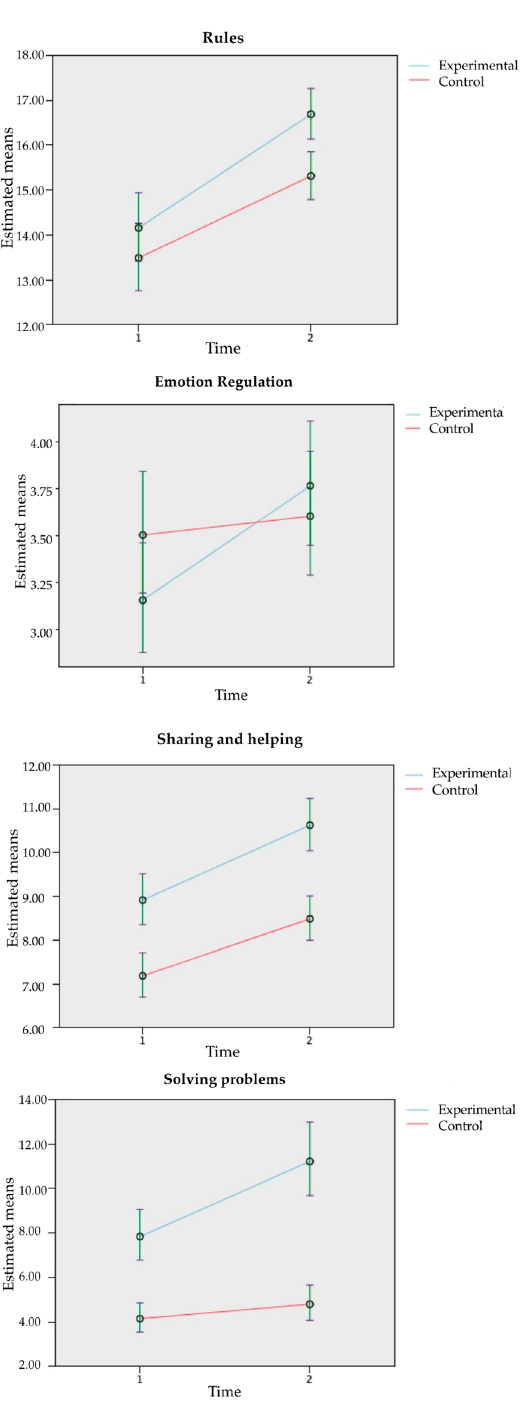
Figure 2. Pairwise contrast in the group*time interaction using the model-estimating means for the program’s variables.